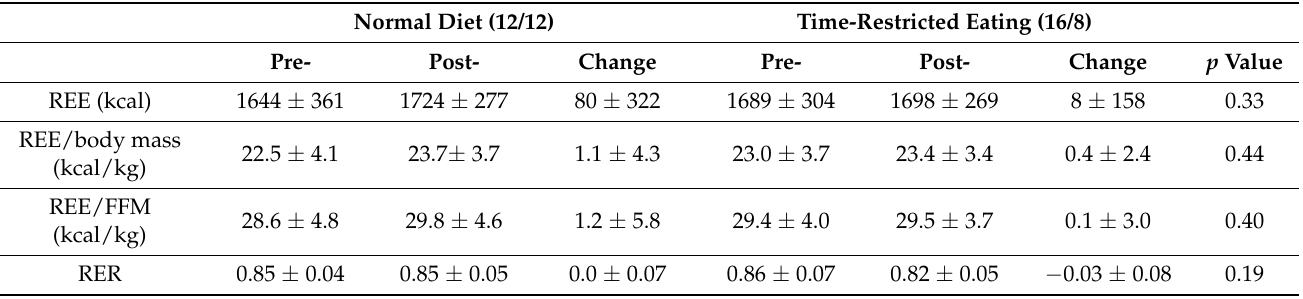
Table 3. Resting Energy Expenditure 1 .